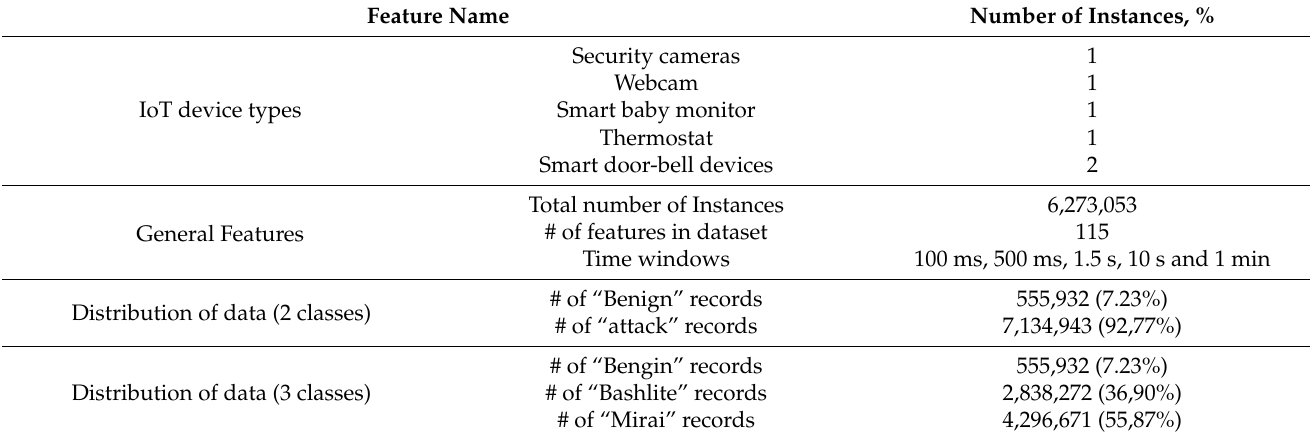
Table 1. Statistics of N-BaIoT dataset.